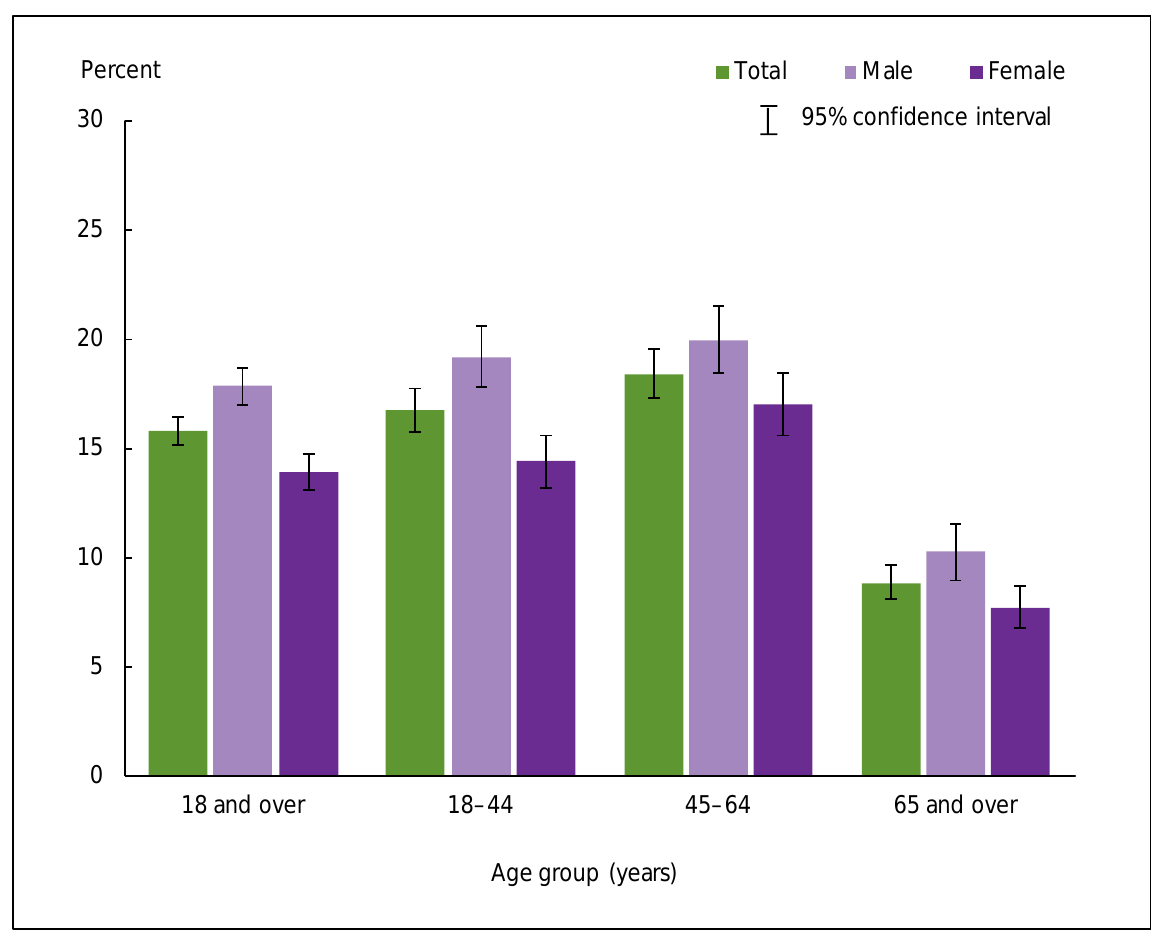
Figure 8.3. Prevalence of current cigarette smoking among adults aged 18 and over, by age group and sex: United States,